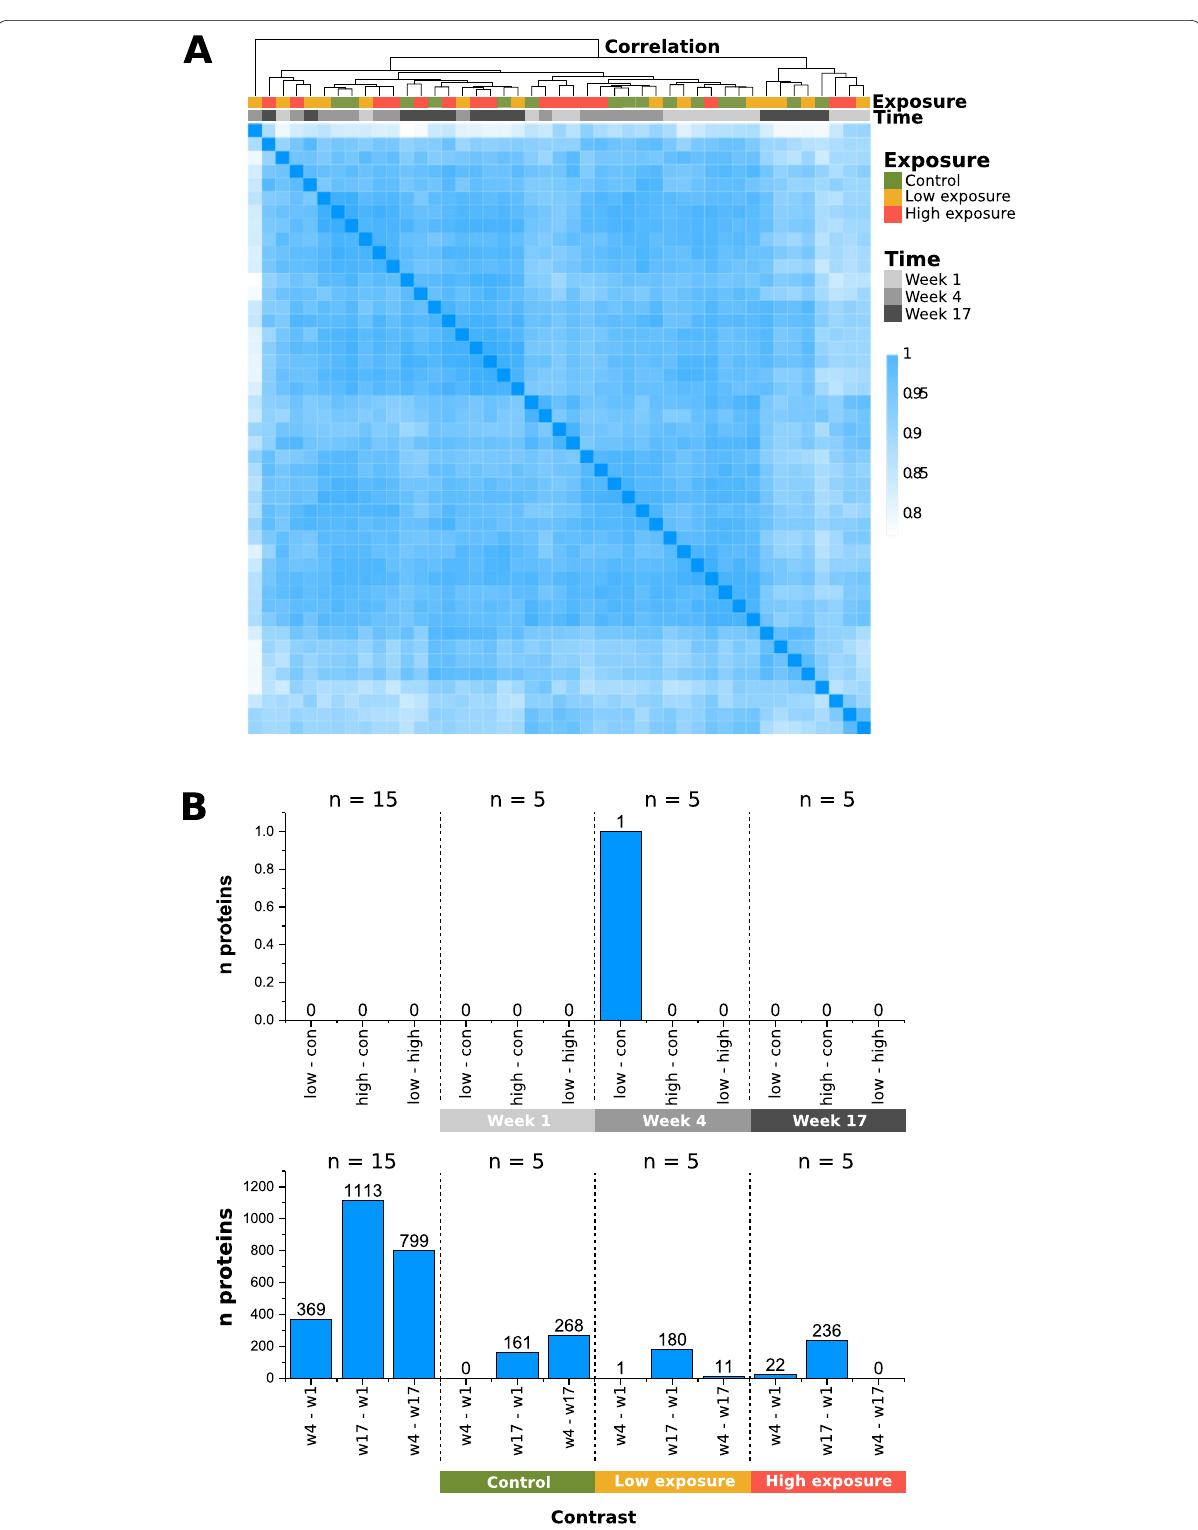
Fig. 5 Overview of the results of the label-free proteomics quantification (LFQ). (A) Heat map based on protein intensity correlation among samples. (B) Number of statistically significantly regulated proteins ( q < 0.05) for each analysed contrast (w exposure, high high exposure). n number of samples in each = =